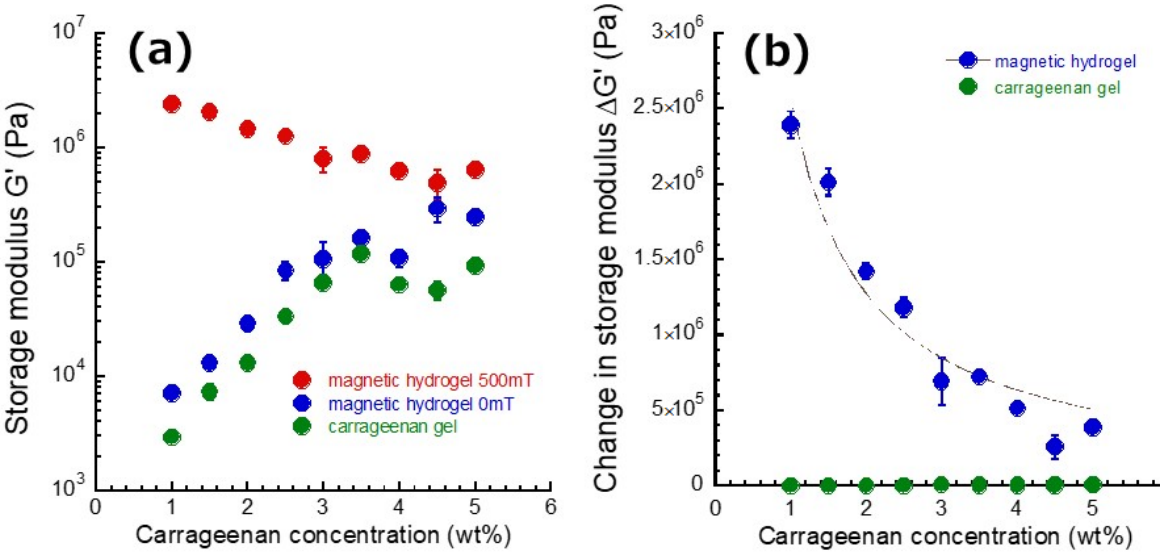
Figure 2. Carrageenan concentration dependence of ( a ) storage modulus at 0 and 500 mT and ( b ) change in storage modulus at 500 mT for magnetic hydrogels (CI: 70 wt%, f = 1 Hz) and carrageenan hydrogels without magnetic